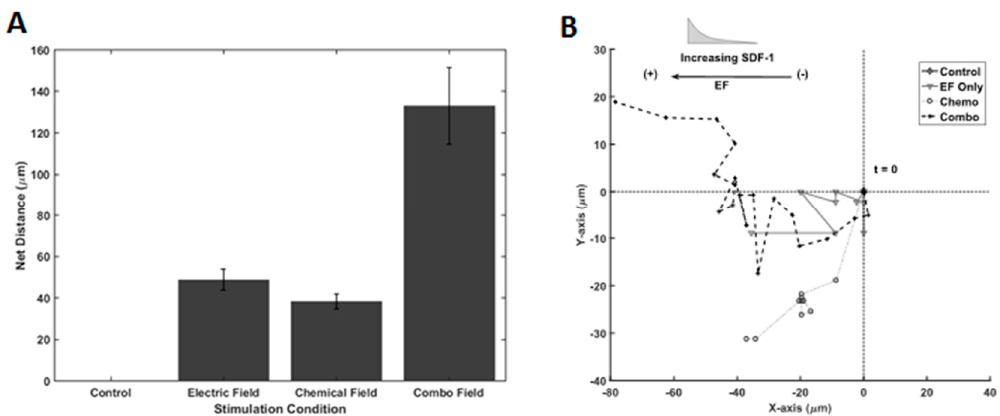
Table 3. Average Retinal progenitor Cells (RPC) Migration Statistics for Various Stimulation Conditions.